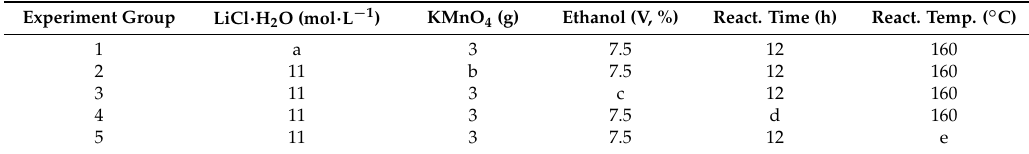
Table 1. Experimental parameters of synthesis LiMn 2 O 4 (LMO) at different